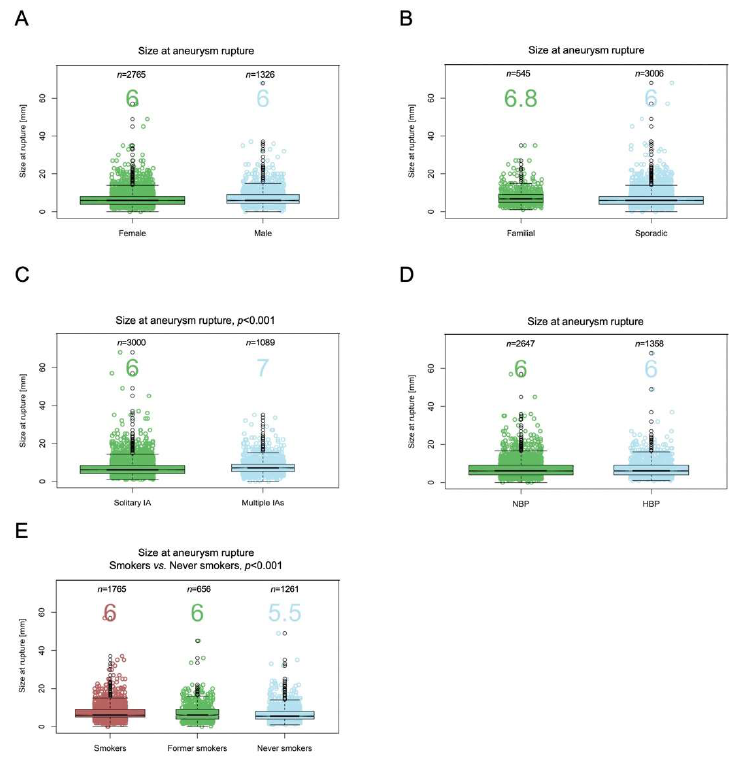
Figure 5. Intracranial aneurysm size at rupture and risk factors for rupture. IA size at rupture by sex ( A ), family history of IA ( B ), IA multiplicity ( C ), blood pressure ( D ), and smoking status ( E ).